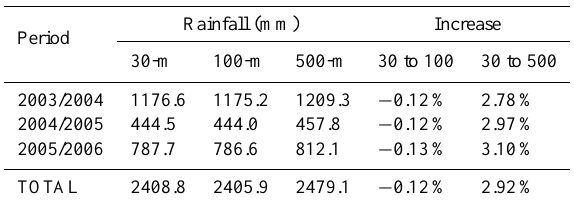
Table 2. Differences in average annual precipitation values at the basin scale between different cell